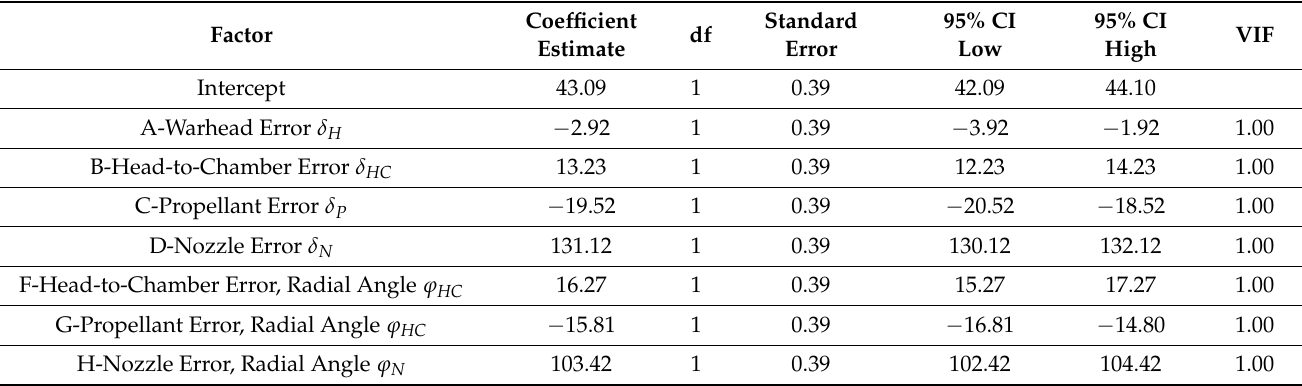
Table 6. Effects for the nine analyzed cases, response variable: drift.